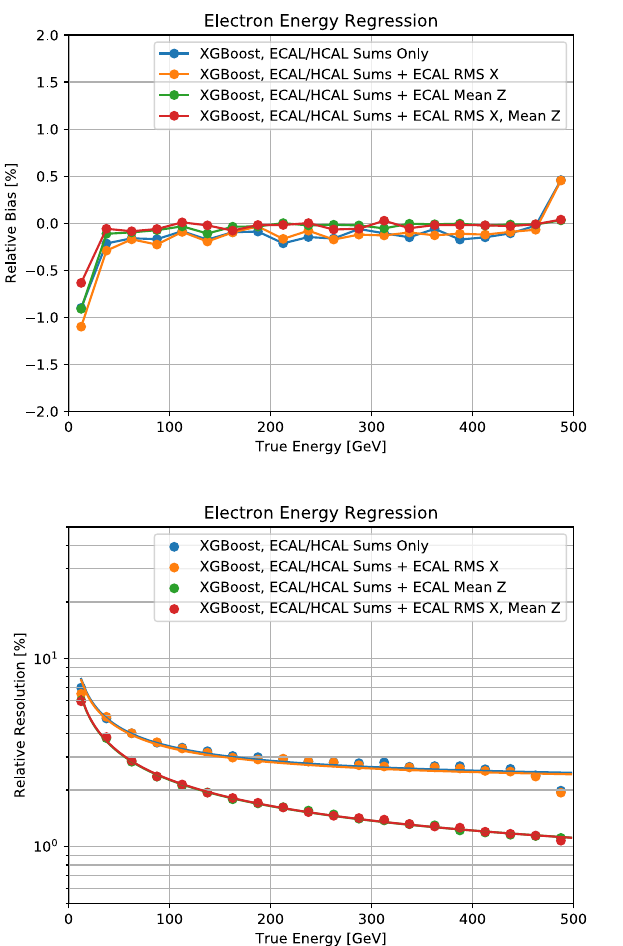
Fig. 28 Bias (top) and resolution (bottom) as a function of true energy for linear regression and XGBoost predictions of particle energy for the different particle